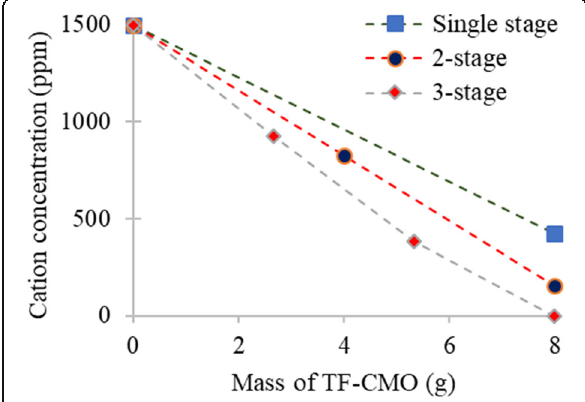
Fig. 7 Comparison of single-stage and multi-stage extraction operations for the treatment of 20 mL of 1500 ppm simulated water using 8 g of